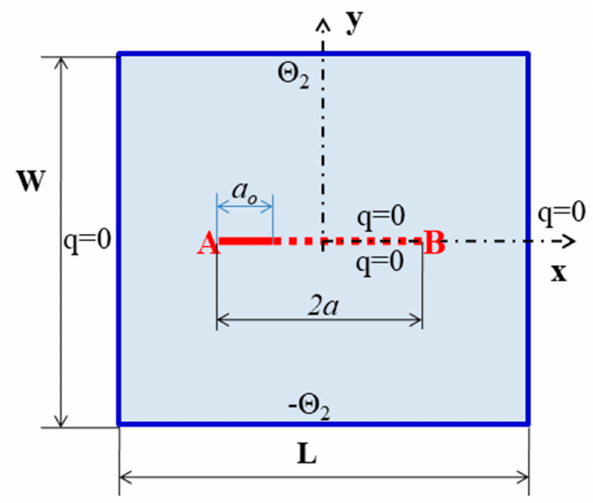
Figure 17. Geometry and the boundary conditions of Example